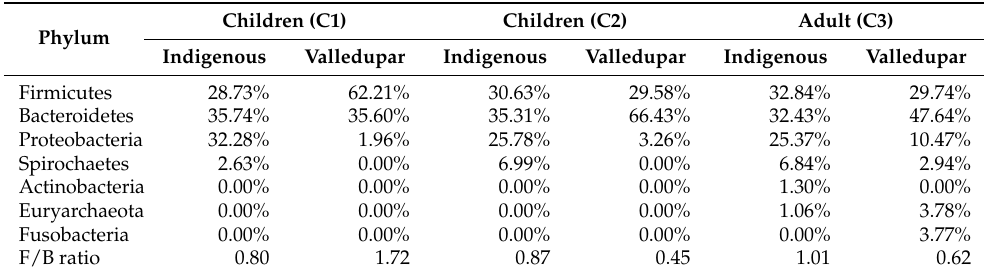
Table A6. Phylum distribution for the age groups in the Indigenous and Valledupar locations. Data indicate relative abundances (percentages of OTU counts). Phyla with relative abundances lower than 1% were filtered out.